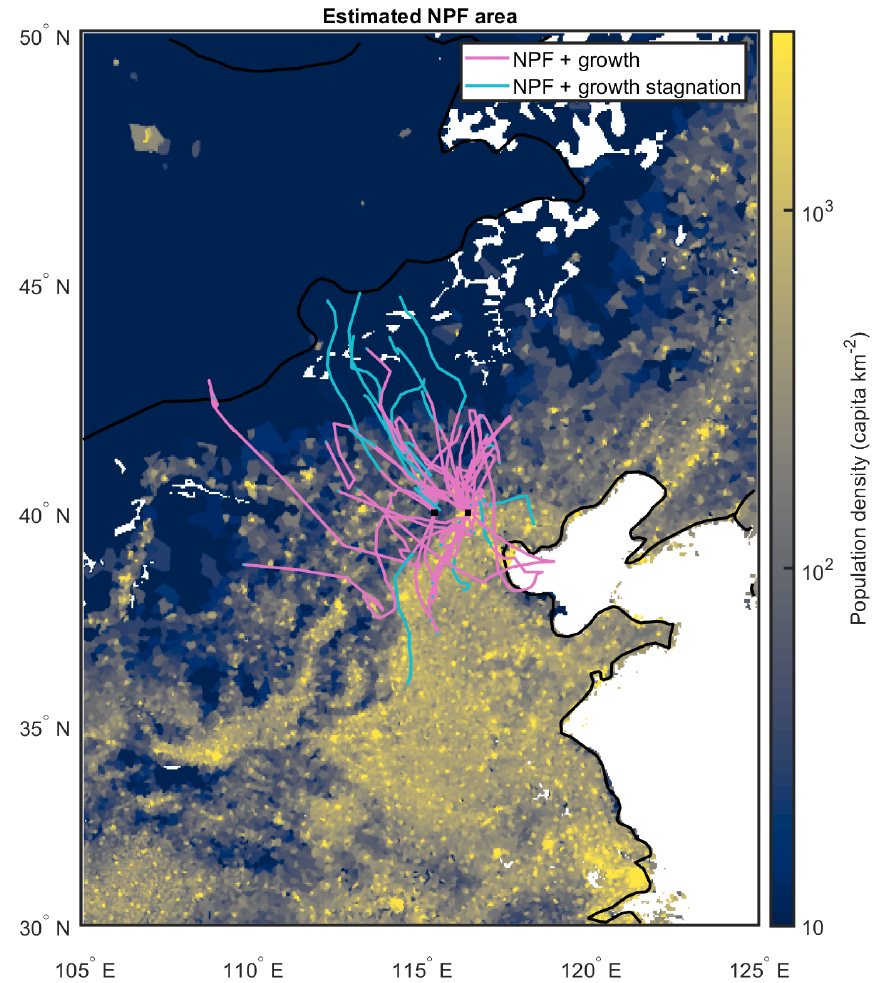
Figure 13. Spatial extent of the area where new particle formation events are estimated to have taken place based on air mass back trajectories and the observed NPF events at both sites. Each line represents a single NPF event and extends to the point beyond which continuation of the mode formed in an NPF event was no longer observed at the measurement site. In other words, if an air mass is located outside the area roughly outlined by the colored lines during the typical onset time of NPF and then transported to our measurement sites, NPF is unlikely to have occurred in said air mass. The lines change color from pink to light blue if the observed NPF event enters a stage of growth stagnation, which can indicate a less favorable environment for the formation and growth of new particles. The lines are overlaid on top of a population density map (Gridded Population of the World; GPWv4.10; CC-BY 4.0), which is used to illustrate the level of anthropogenic activities and